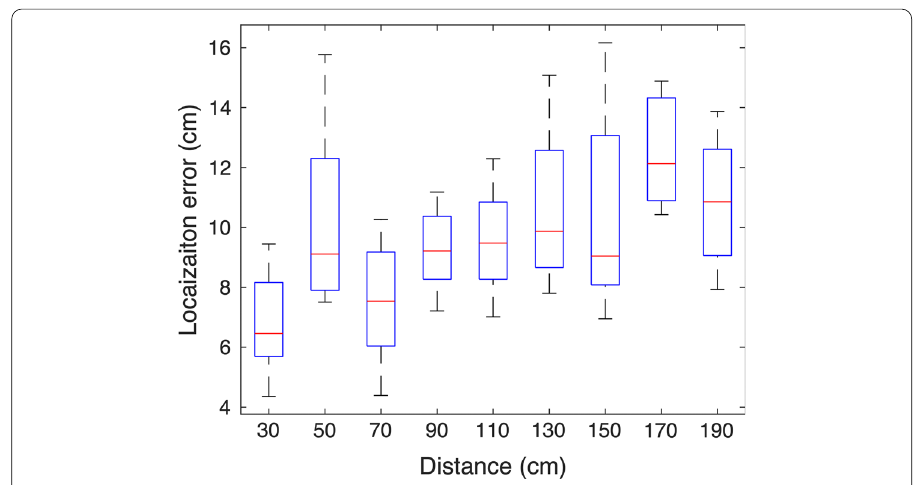
Fig. 8 Positioning error at different distances